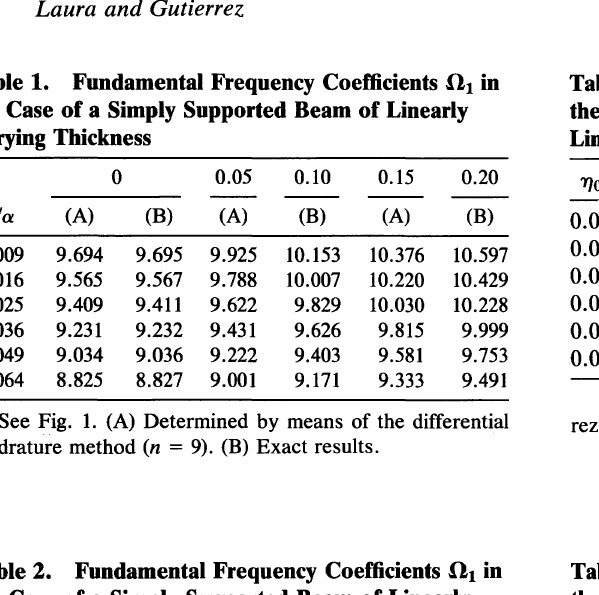
Table S. Fundamental Frequency Coefficient fil